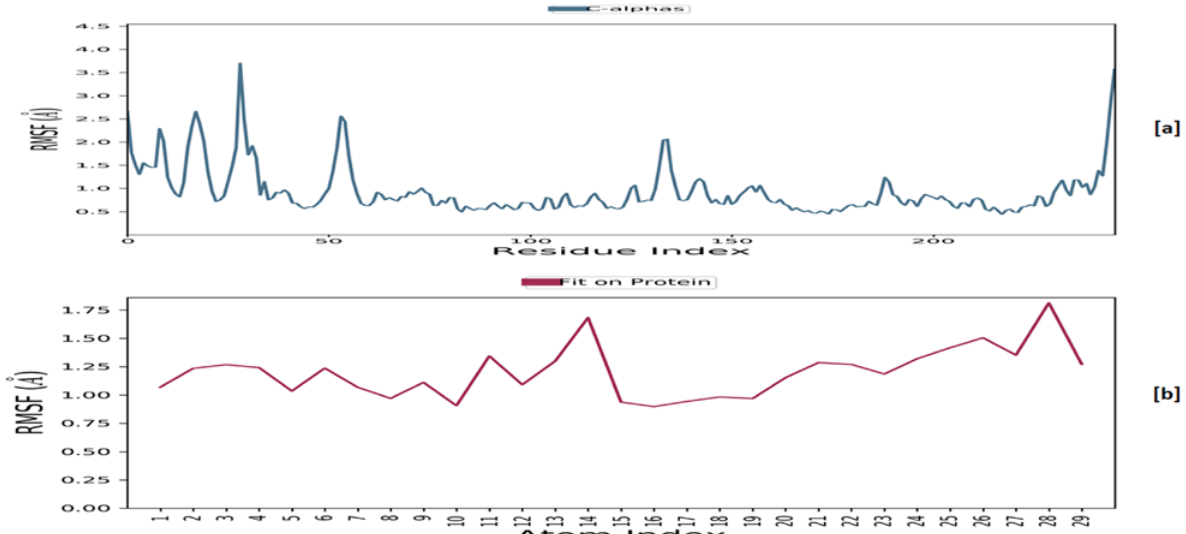
Figure 14. The RMSF plot for MM137 and CHK1: RMSF for the MM137 ( a ) and the macromolecular backbone of CHK1 ( b ) obtained after MD simulation.